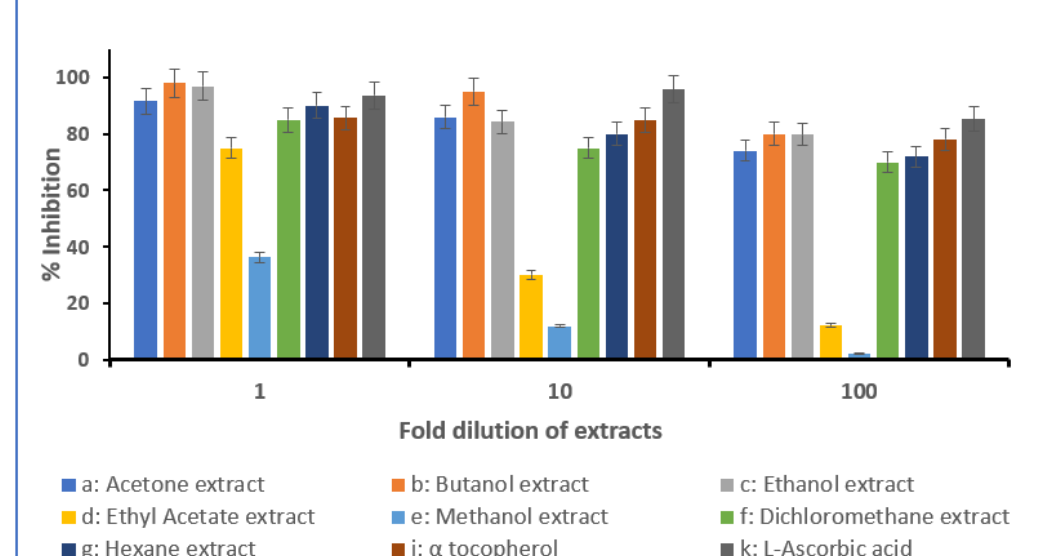
Figure 1. Antioxidant activity of Anastatica hierochuntica extracts by DPPH method. Various extracts